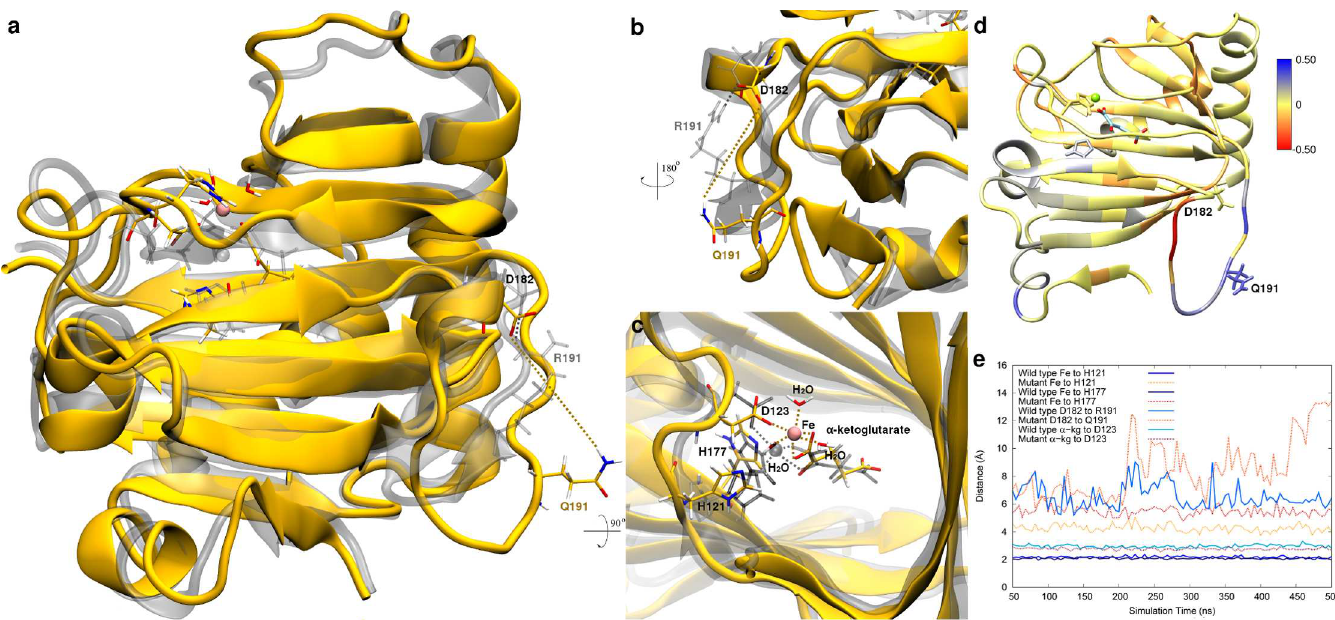
Fig 1. Structural and dynamic comparison between WT and R191Q ALKBH7with bound α -kg. a, Overlay of representative structures for WT (gray) and R191Q mutant (yellow)forms of ALKBH7. Active site residues and α -kg as well as the site undergoingsubstitutionare displayed(licorice). b, 180 degree rotation and close-upof the substituted site. c, 90 degreerotation and close-up of the active site, with each relevant active site residue and α -kg labeled. Dashedlines in gray represent the originalbonds to the metal ion in the crystal structure, and dashedlines in orangerepresentthe new bondsto the metal ion near the end of the trajectory for the variant protein. d, Correlation difference for each residue in the WT protein with respect to the R191Q variant mappedonto the protein structure using the mutation site as the reference. e, Distanceanalysisfor key residues in the SNP variant and active sites (with respect to their centers of mass) throughoutthe